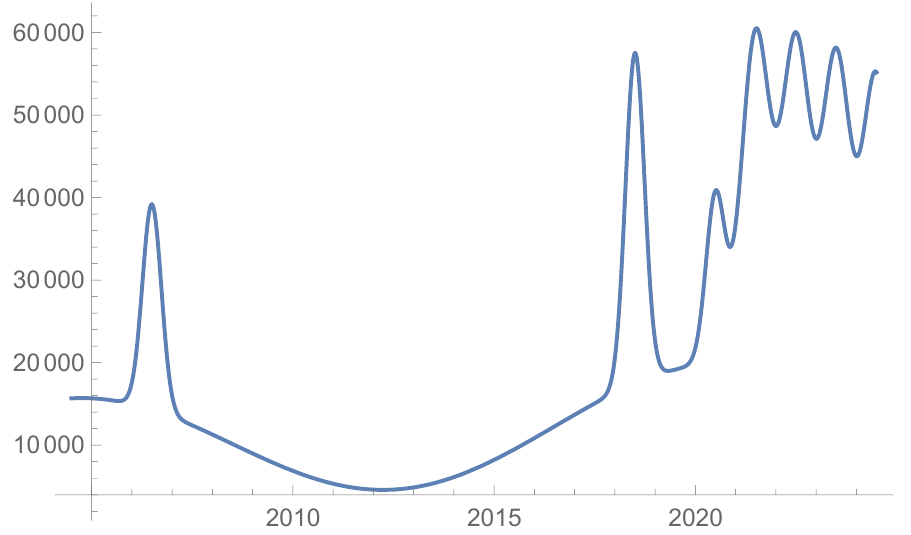
Figure 3. Incoming irregular immigration forecast.